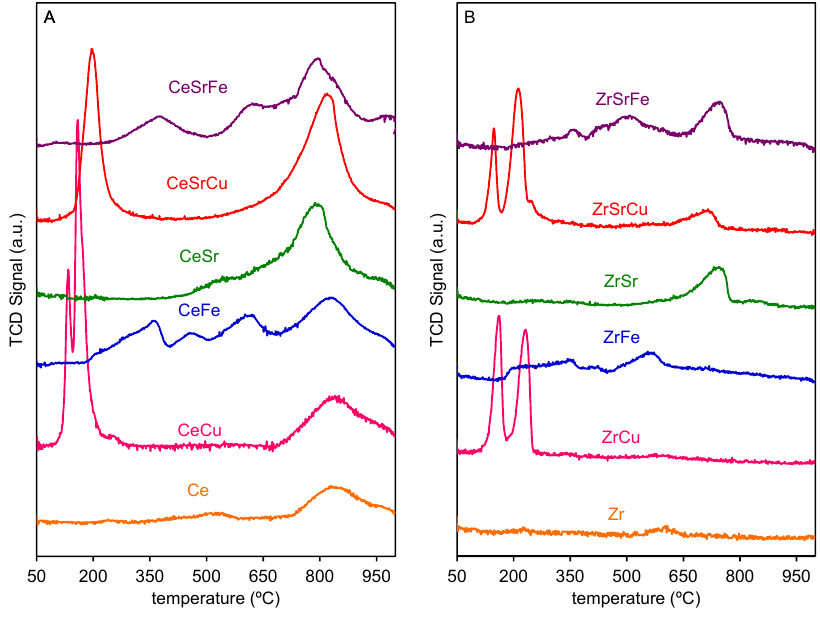
Figure 2. H 2 ‐ TPR profiles for ( A ) Ce ‐ and ( B ) Zr ‐ based catalysts. Figure 2. H 2 -TPR profiles for ( A ) Ce- and ( B ) Zr-based